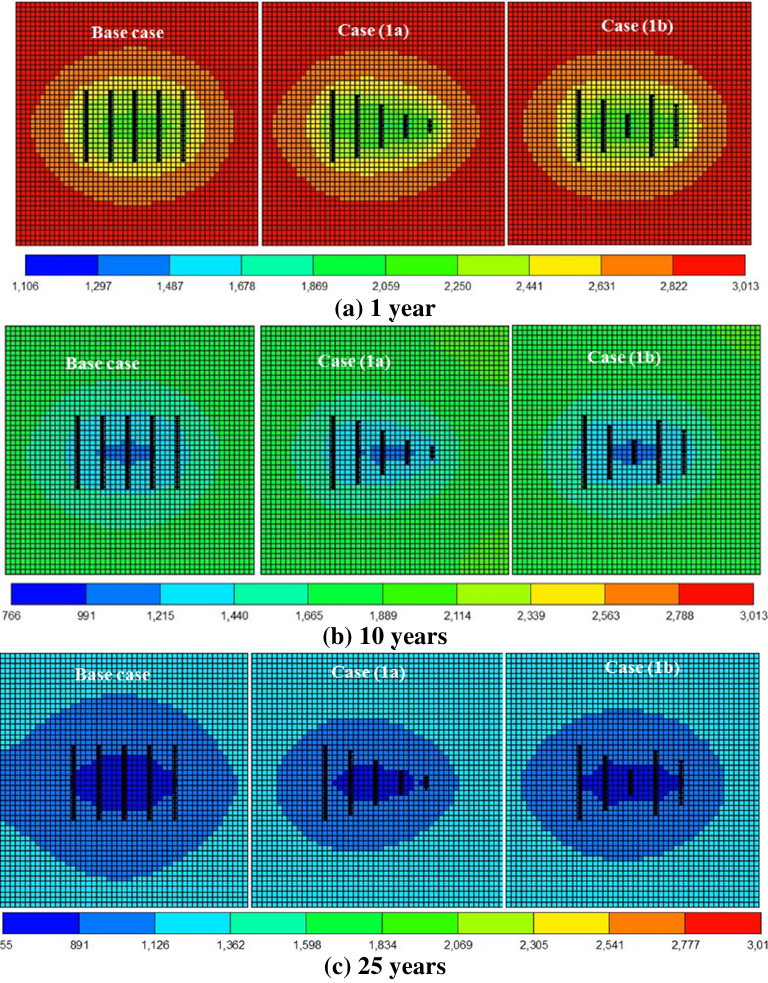
FIG. 2. COMPARISON OF PRESSURES AT DRAINAGE BOUNDARY AT DIFFERENT TIME PERIODS